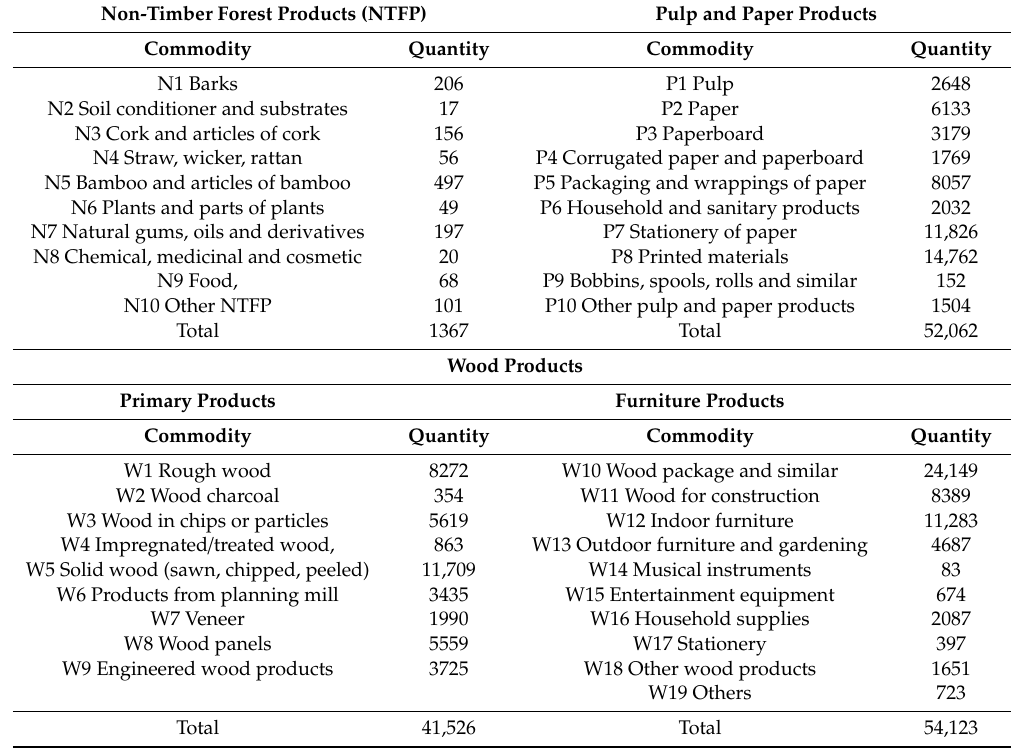
Table 2. Number of di ff erent categories of FSC-certified forest products.